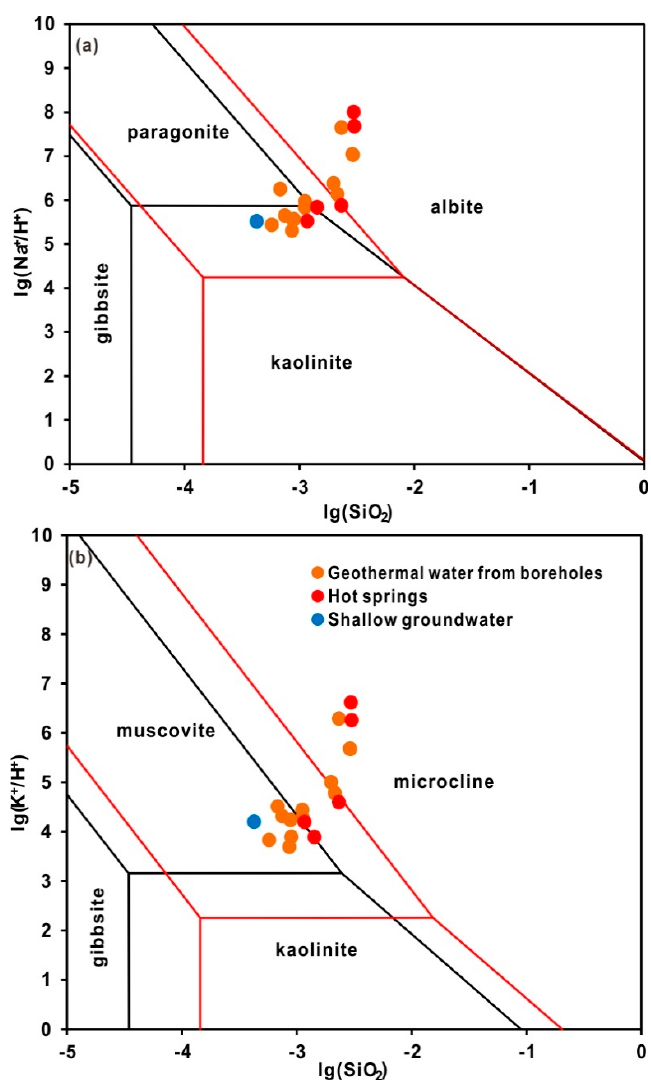
Figure 6. Equilibrium of the water samples with aluminosilicate minerals: ( a ) Na 2 O-Al 2 O 3 -SiO 2 -H 2 O system, ( b ) K 2 O-Al 2 O 3 -SiO 2 -H 2 O system. The phase boundaries are plotted for 100 °C (in black) and 200 °C (in red).